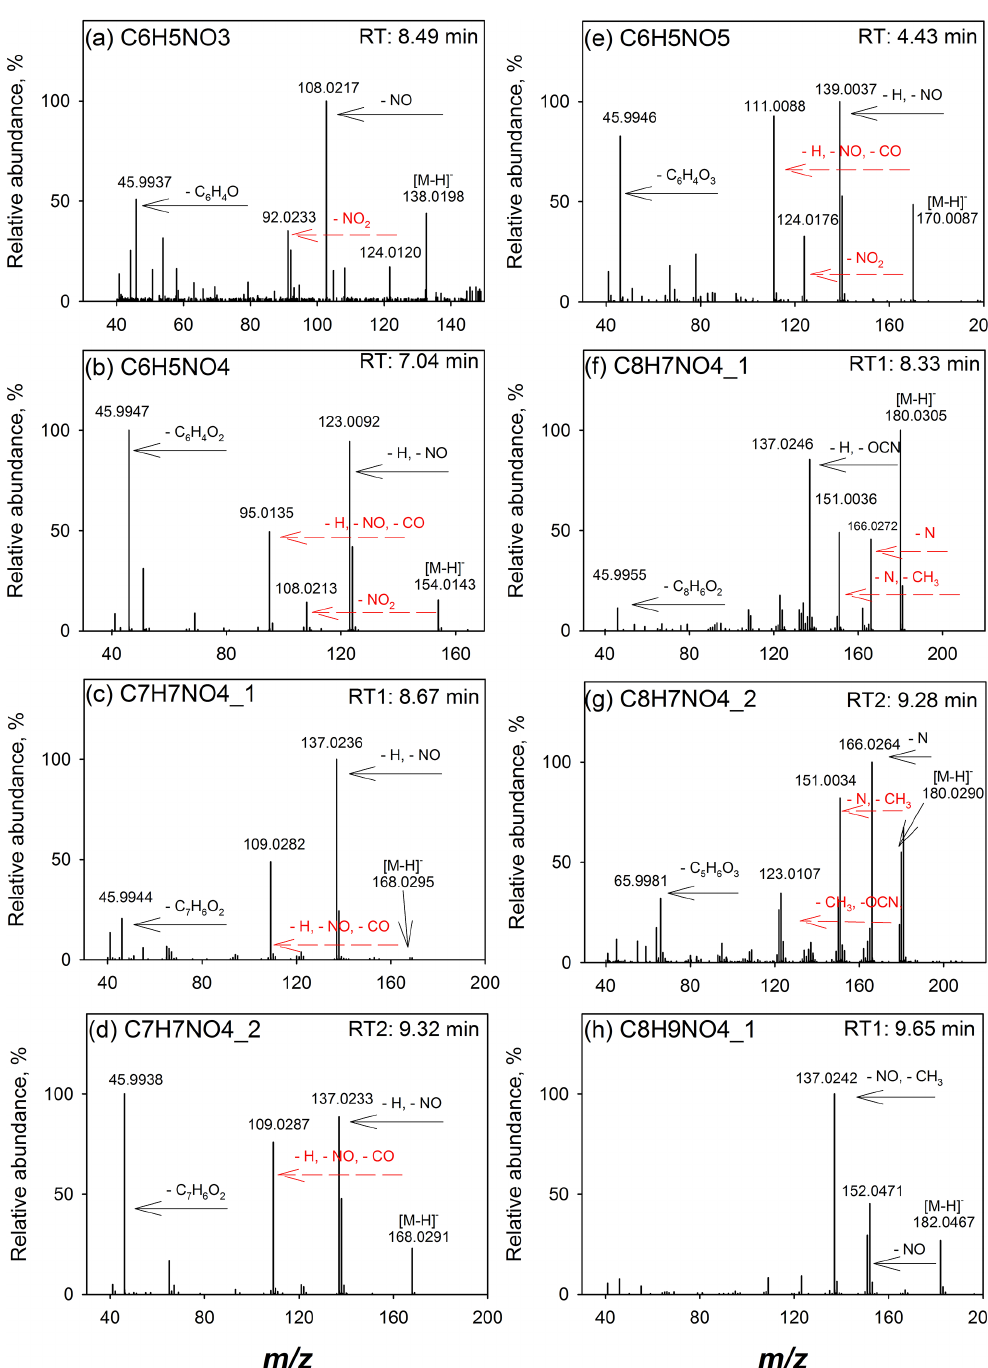
standard compound with hydroxyphenyl cyanate structure is tion was conducted using the internal standard method with not commercially available, C 8 H 7 NO 4 and C 9 H 9 NO 4 were nine-point calibration curves ( ∼ 0 . 01–2 ngµL − 1 ). The com- quantified as 2-methyl-5-nitrobenzoic acid (C 8 H 7 NO 4 ) and pounds corresponding to each NAC formula (including iso- 2,5-dimethyl-4-nitrobenzoic acid (C 9 H 9 NO 4 ), respectively; mers) were quantified individually and added together for all the identified NACs with MW > 200 Da were quantified the calculation of mass contribution (%) to organic matter as 2-nitrophloroglucinol (C 6 H 5 NO 5 ). The mass quantifica- (OM µgm − 3 ) in each sample. The quality assurance and con- Atmos. Chem. Phys., 19, 2899–2915, 2019